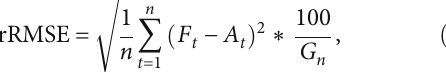
index . Processed data from the 2008 year for a forecasting DR